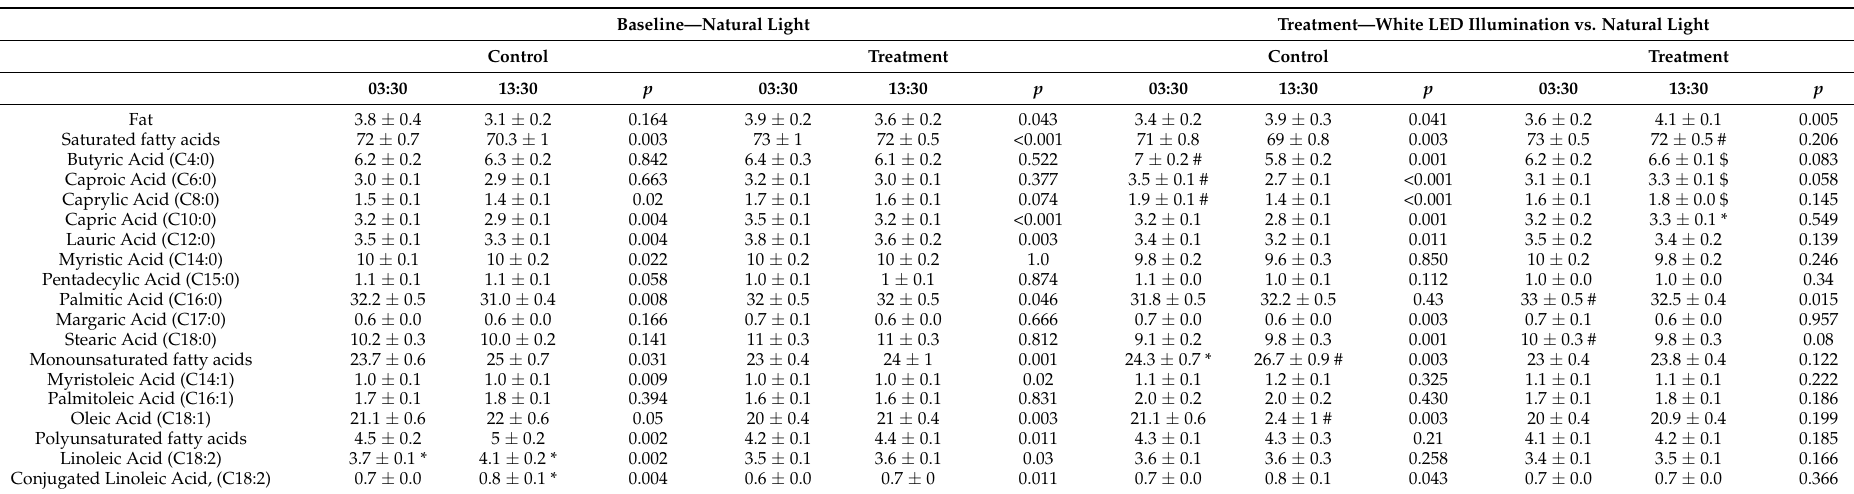
Table A3. The proportions of total fat in whole milk (g/100 mL of milk) and of fatty acids in milk fat (g/100 g of milk fat), according to milking time and experimental phase (i.e., illumination